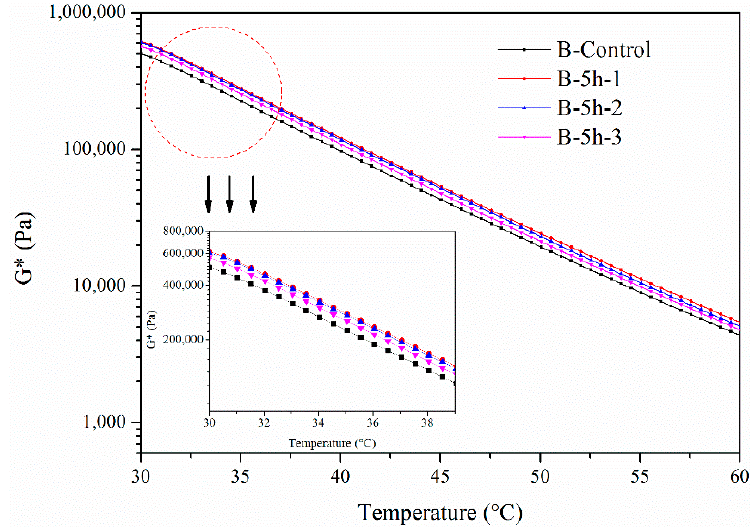
Figure 5. Complex modulus of B aged by UV radiation for 5 h.